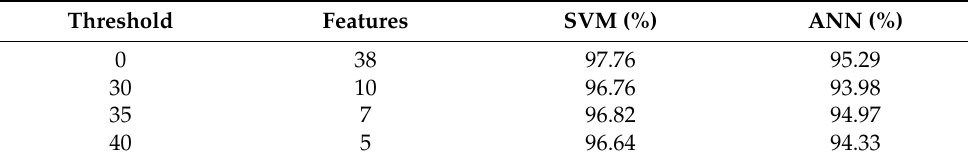
Table 2. Accuracy percentage of SVM and ANN for different threshold values according to Figure 9. Threshold